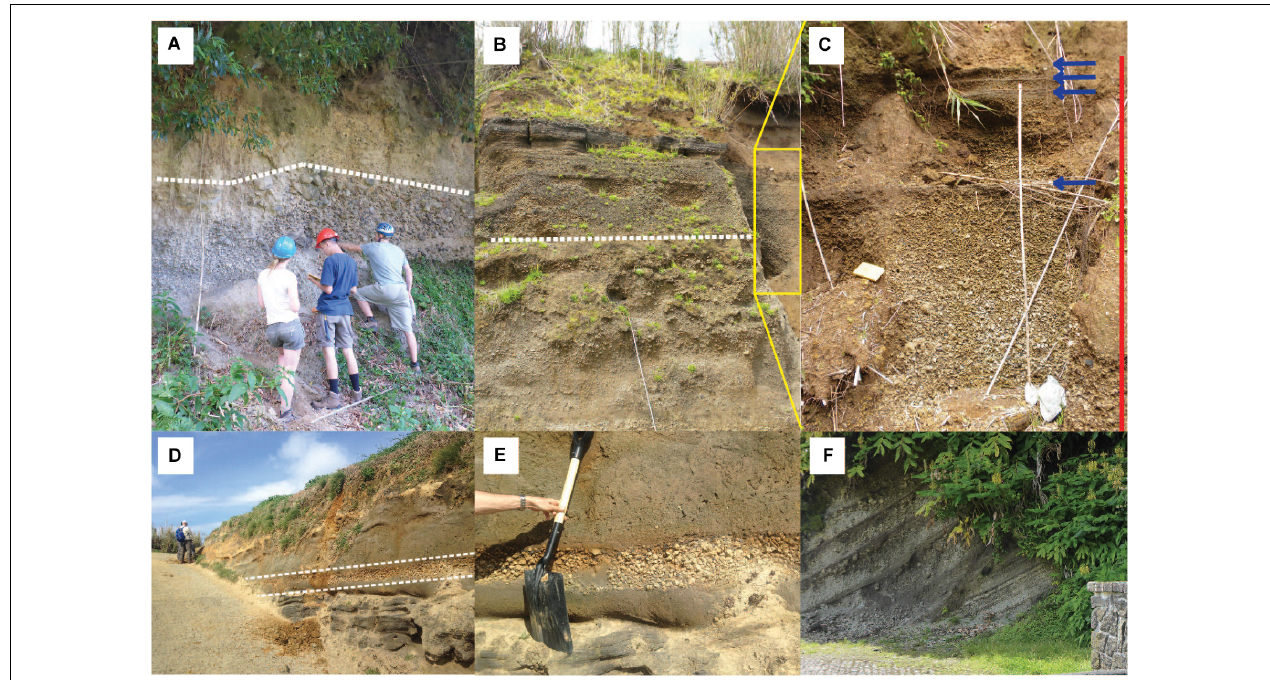
FIGURE 2 | General aspects of outcrops of the Santa Bárbara Formation (SBF). (A) Outcrop A, sampling location for samples 7C01 and 7C02 near Candelária ( Figure 1 ). Two different PDC deposit lithofacies from the Middle Member showing massive lapilli tuffs with variable content of lithic clasts (white dashed line indicating the boundary). (B) Type locality (UK080, MP020) of the Middle and Upper Members near the village of Santa Bárbara; outcrop B for samples 7C03 and 7C04 ( Figure 1 ), showing massive lapilli tuffs in the lower half (below dashed line), overlain by massive pumice fall deposits showing normal grading (height of outcrop 8 m). (C) Zoom into Figure 2B , see yellow box for stratigraphic location. General aspect of the two pumice lapilli beds of the Upper Member separated by a 12 cm ash layer (field book for scale). Red vertical line (approximately 3.5 m) shows the vertical extent. Blue arrows indicate the presence of thin ash layers. (D) In a road cut at Ponta do Cintrão (Outcrop C for samples 7C05 and 7C06), a pumice lapilli fall deposit in between two paleosol layers shows similar features to the proximal Upper Member of the SBF (between dashed lines). (E) Close-up of the pumice lapilli fall deposit of Figure 2D , sharing many characteristics and textures